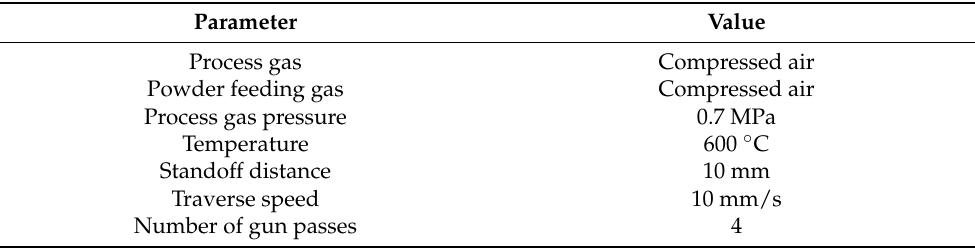
Table 2. Cold spraying deposition parameters.